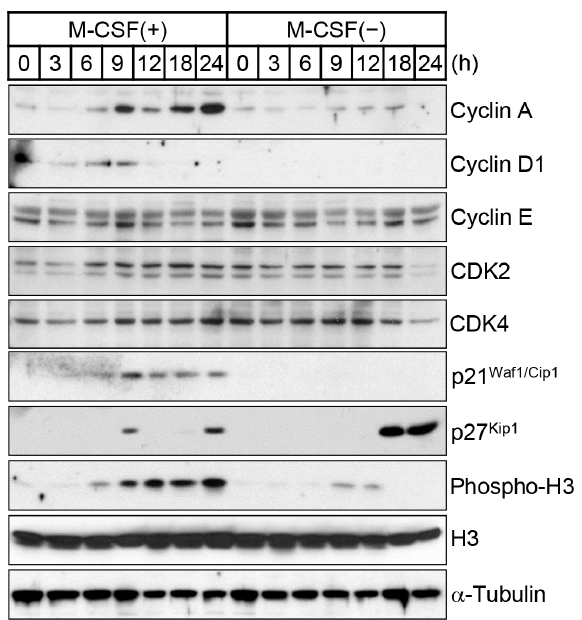
Figure 3. Change in expression levels of cell cycle regulators during M-CSF deprivation. Cells cultured for the indicated times were lysed and subjected to immunoblot analysis with antibodies to the indicated proteins.